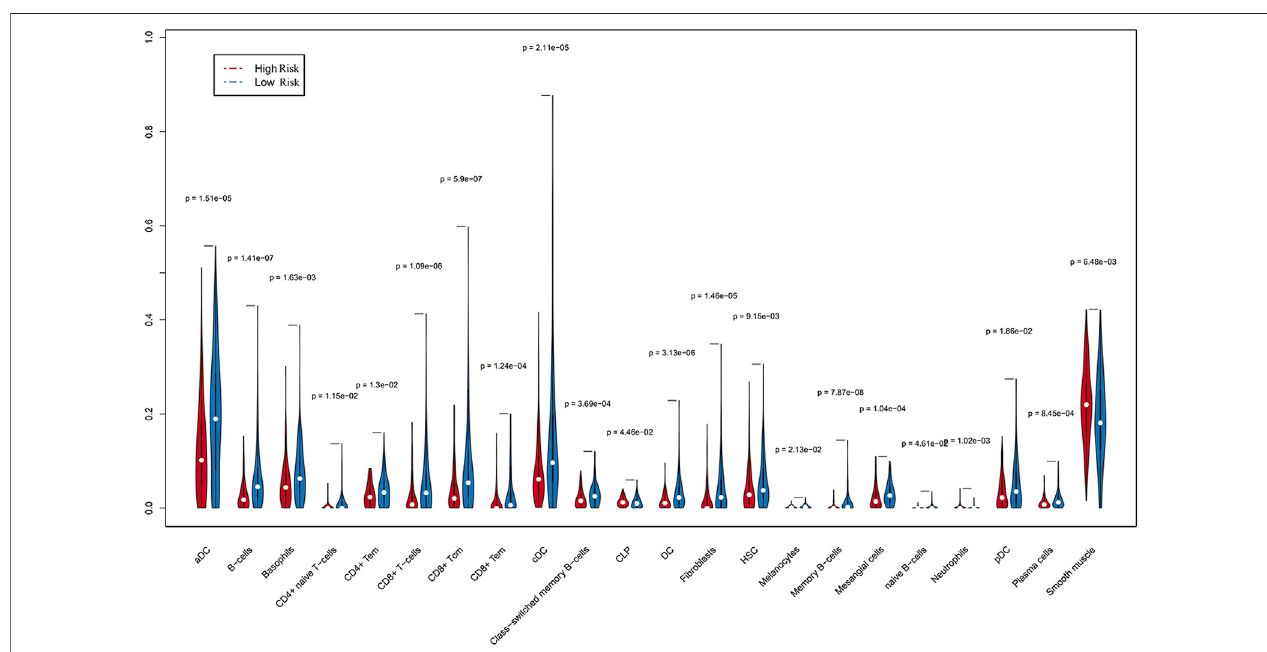
FIGURE 6 | Differences in immune cells screened from 64 mesenchymal cells were accurately compared by Wilcoxon rank and testing ( p < 0.05), indicating that a few immune cells gave different in fi ltrating densities in two risk